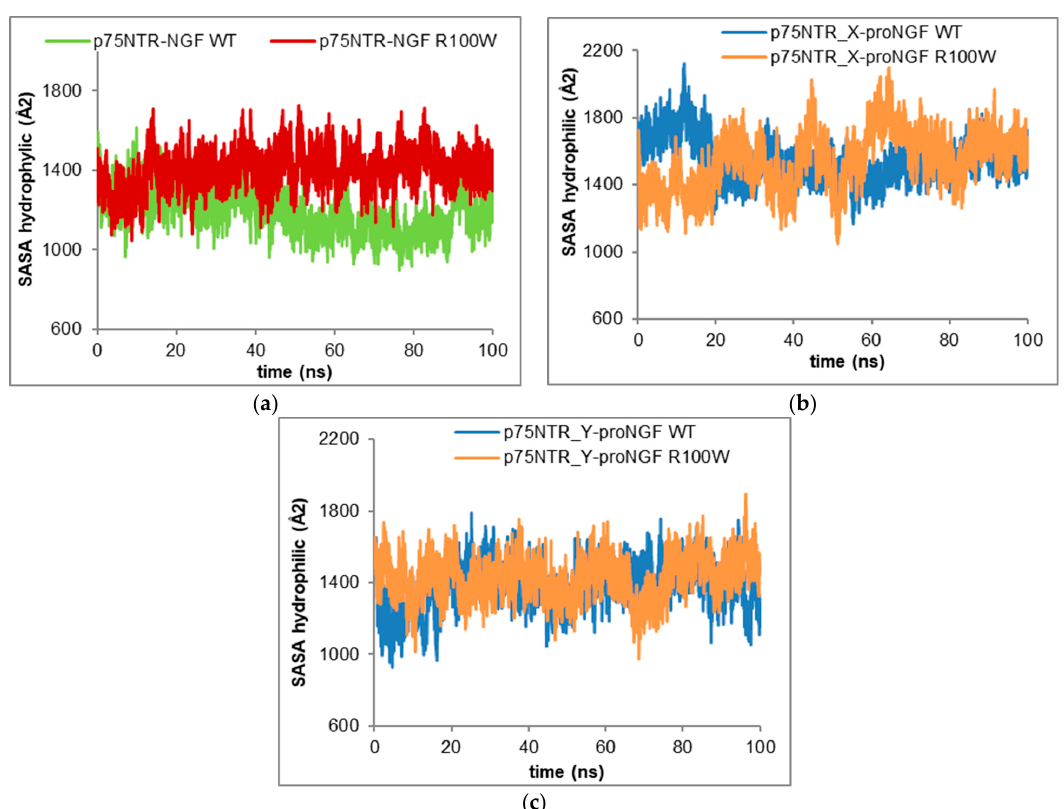
Figure 8. Time-evolution hydrophilic Solvent Accessible Surface Area trajectories of the complexes : ( a ) p75NTR/NGF, ( b ) p75NTR_X/proNGF, and ( c ) p75NTR_Y/proNGF. ( a ) p75NTR/NGF, ( b ) p75NTR_X/proNGF, and ( c )